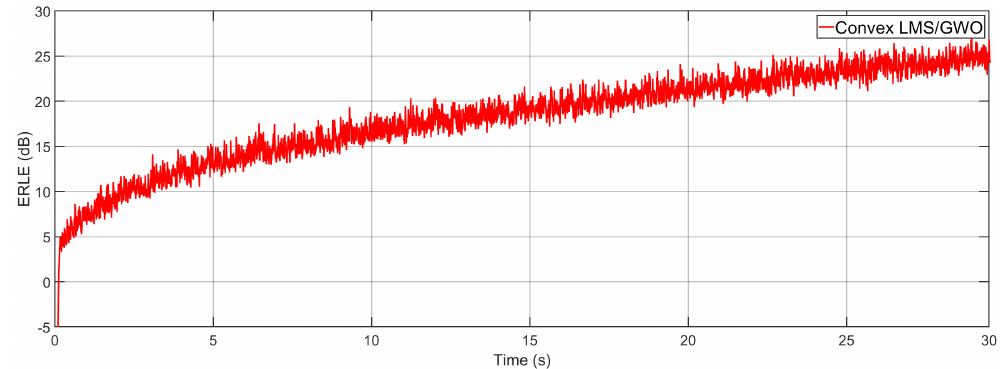
Figure 14. ERLE learning curve of the proposed convex GWO/LMS considering an AR(1) process as input